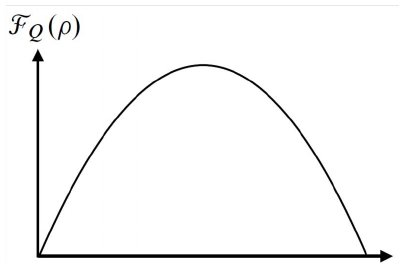
Figure 1. Behavior of the quantum Fisher information as a function of a | α | 2 . For | α | = 0,1, the state is the energy eigenstate and the Fisher information becomes